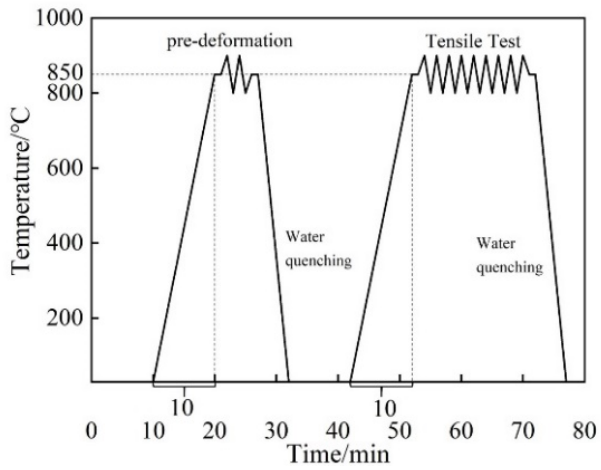
Figure 1. ( a ) Design of the hot tensile test specimen; ( b ) hot tensile fixtures.